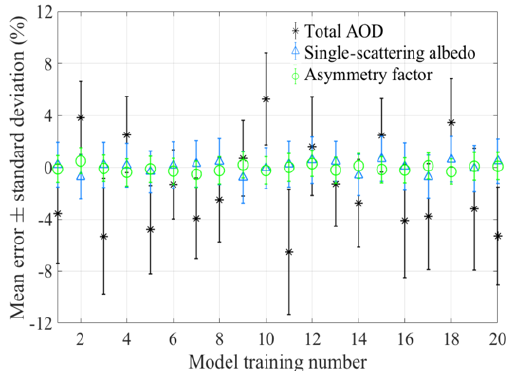
Figure 15. Effect of random noise in model training on the retrieved aerosol properties.